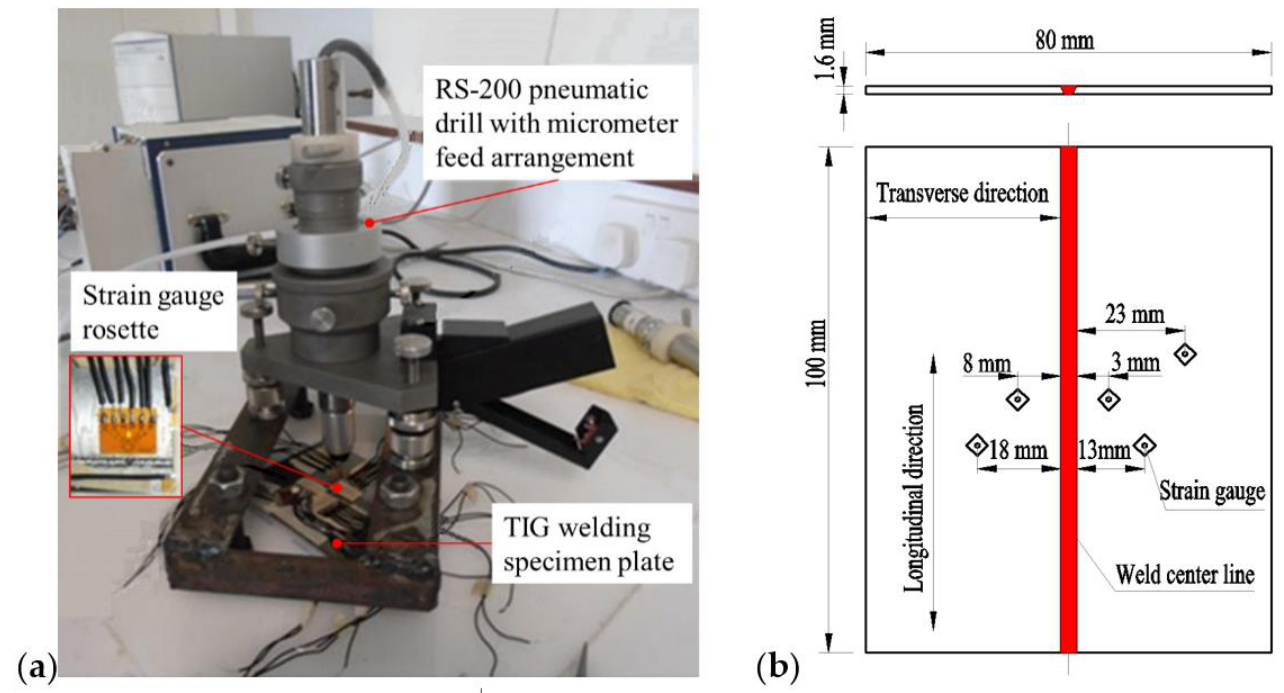
Figure 5. Measurement of residual stress by drilling method. ( a ) Measuring device, ( b ) measuring residual stress location.